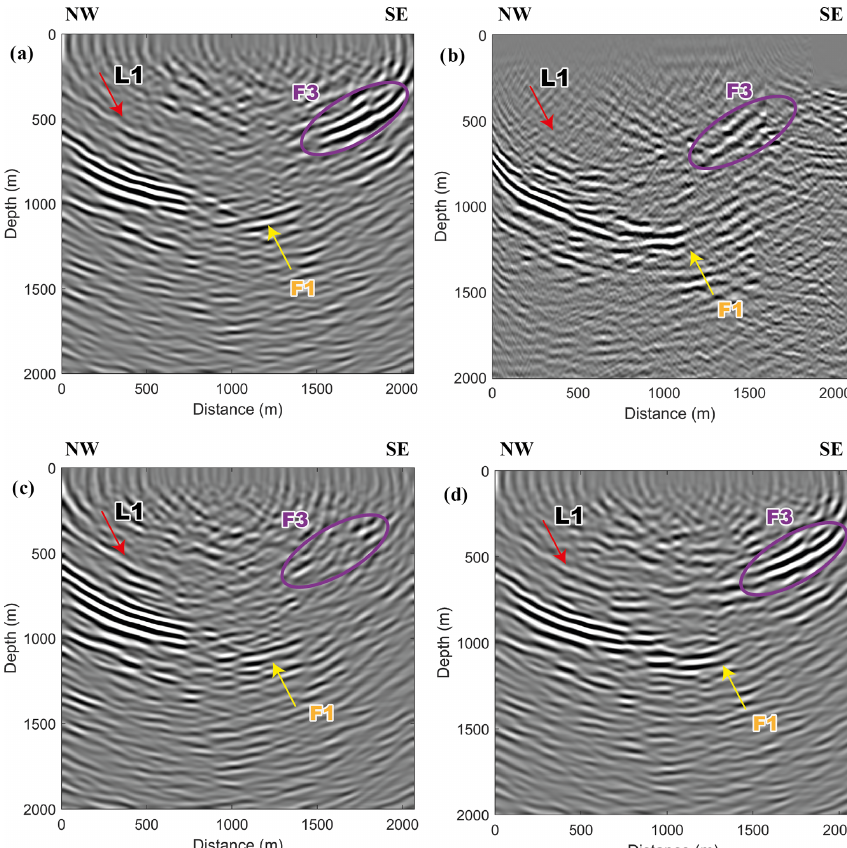
Figure 11. Comparisons of different image results. (a) The RTM image (same as Fig. 10). (b) Image produced by a poststack Kirchhoff migration in Markovic et al. (2020). (c) RTM image obtained from data without offset regularization in the pre-processing (Step 4). (d) RTM image obtained from data with median filter applied in the pre-processing (Step